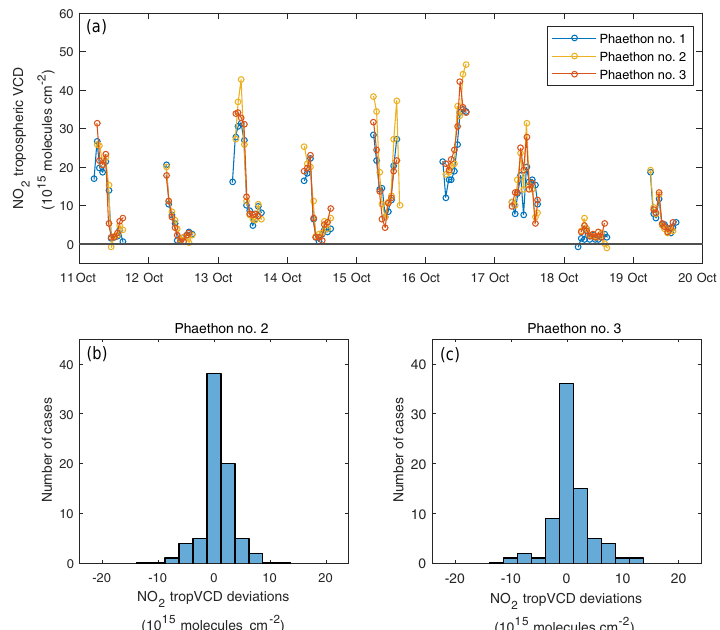
Figure 4. The Phaethon systems were operating in parallel at the university campus from 11 to 19 October 2014. (a) Hourly mean NO 2 tropospheric VCD time series of the three systems retrieved for 15 and 30 ◦ elevation angles. (b, c) Histograms of the NO 2 tropospheric VCD differences of Phaethon #2 and #3 relative to Phaethon